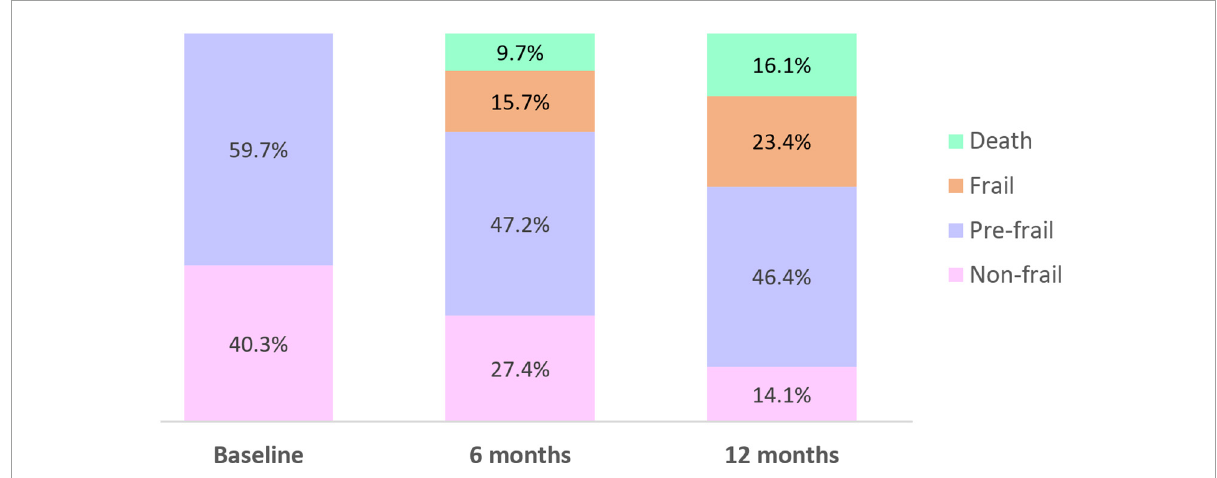
FIGURE1 Proportion of participants who were non-frail, pre-frail, frail, or died over the 12-month study